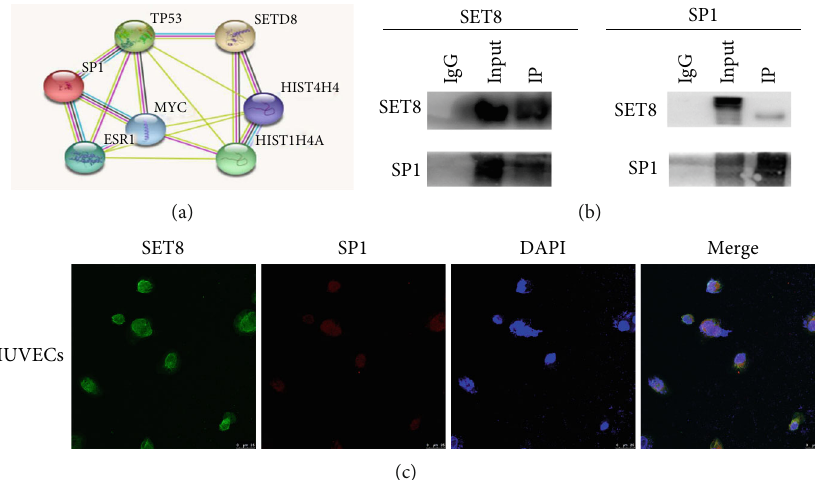
Figure 4: SET domain-containing protein 8 (SETD8) interacted with speci fi city protein 1 (SP1). (a) Several transcription factors that interact with SETD8 (https://string-db.org). (b) The interaction between SETD8 and SP1 in HUVECs was measured by immunoprecipitation. SETD8 was detected to interact with SP1 in HUVECs by Co-IP. (c) Colocalization of SETD8 and SP1 in HUVECs as detected by confocal